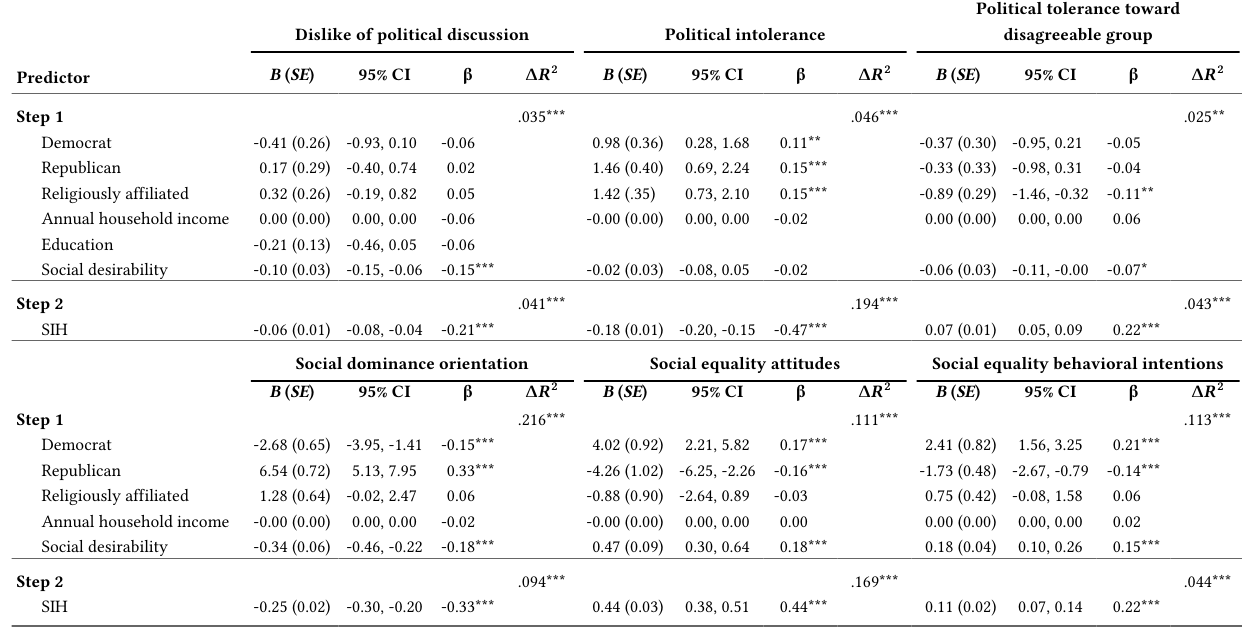
Note. Democrat and Republican were coded 1 if identifying with the party in question, 0 otherwise. Religious affiliation was coded as 1 = religious (including Christian, Hindu, Muslim, Jewish, Buddhist, and other religions) and 0 = not religious (including spiritual but not religious, agnostic, atheist, and